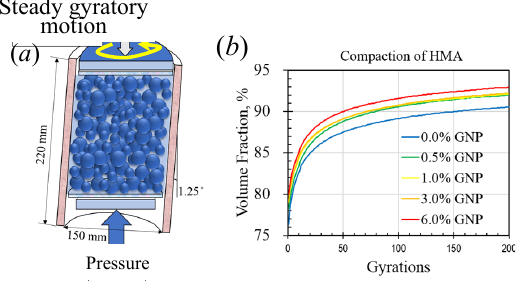
Fig. 1. (a) Schematic dynamics of a SuperPave Gyratory Compactor. (b) Experimental measurements using a Brovold SuperPave Gyratory Compactor showing relationship between number of gyrations and the volume fraction of a hot asphalt mixture (HMA) with different amounts of added graphene nano-platelets